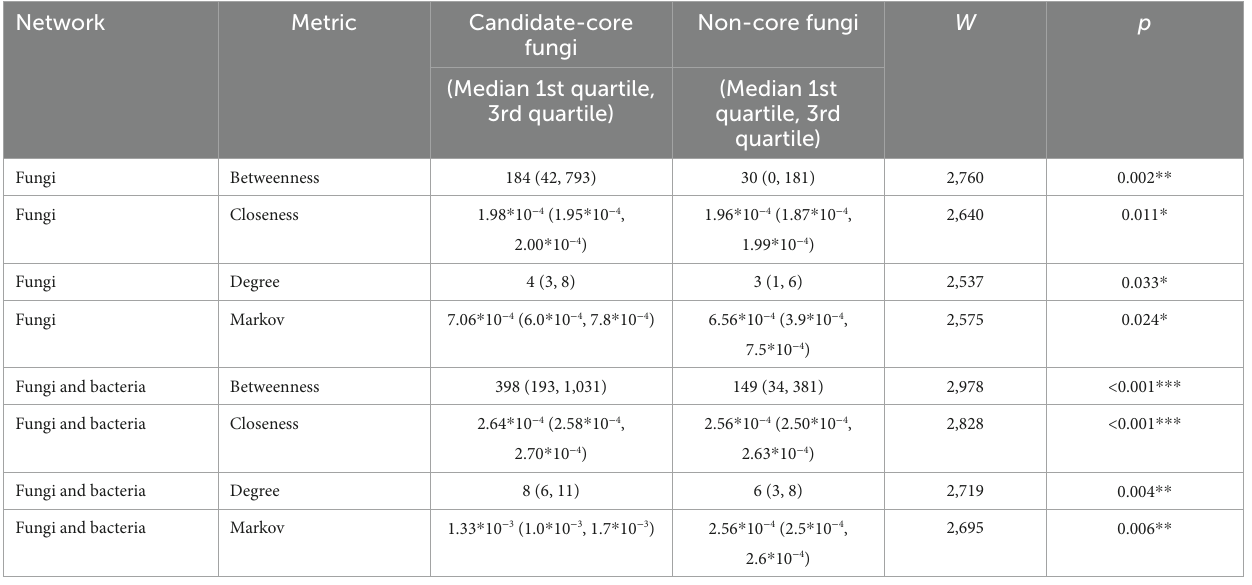
TABLE 3 Results from Wilcoxon sum rank tests of centrality metrics from fungal OTUs considered core and non-core.